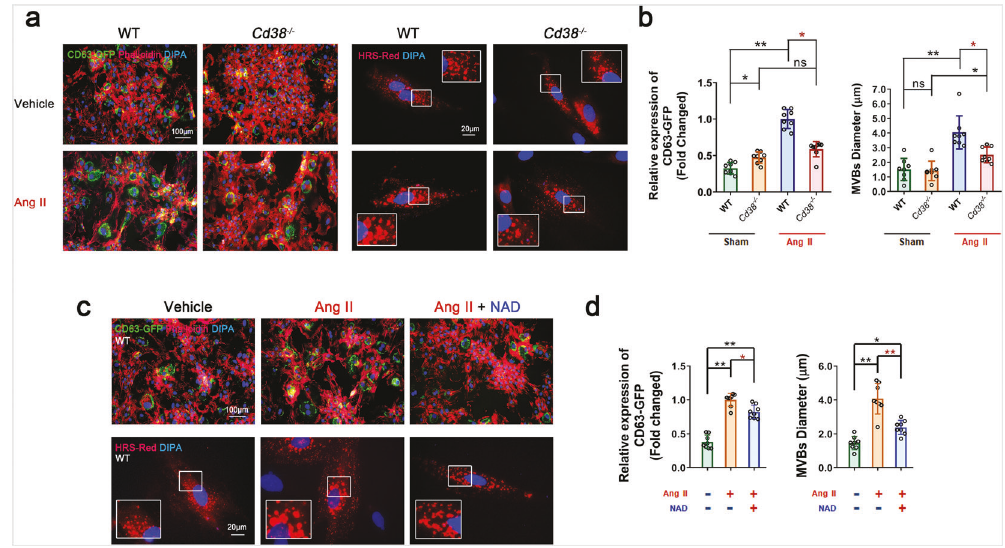
Fig. 5 CD38 de fi ciency and NAD supplementation suppressed sEV biogenesis by inhibiting MVB formation. a , b The numbers of CD63-GFP- positive exosomes and HRS-RFP-positive MVBs were reduced in Cd38 − / − VSMCs stimulated with Ang II for 3 days. Phalloidin was used to show the cytoskeleton in red. ( n ≥ 5, one-way ANOVA, * p < 0.05, ** p < 0.01). c , d The numbers of CD63-GFP + exosomes and HRS-RFP + MVBs were reduced by NAD supplementation coupled with Ang II stimulation for 3 days ( n ≥ 5, one-way ANOVA, * p < 0.05, ** p <